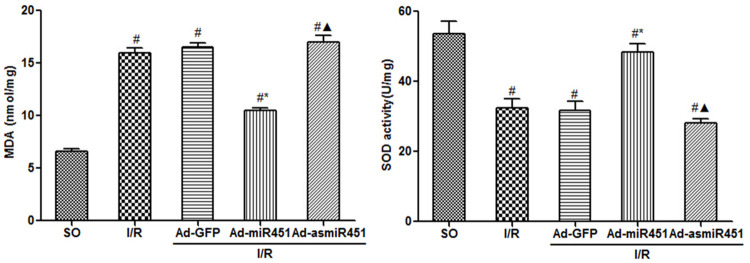
Effect of miR-451 on MDA and SOD in I/R.#: vs P<0.05 compare with SO group; *: P<0.05 compare with I/R group; ▲: P>0.05 compare with I/R group.